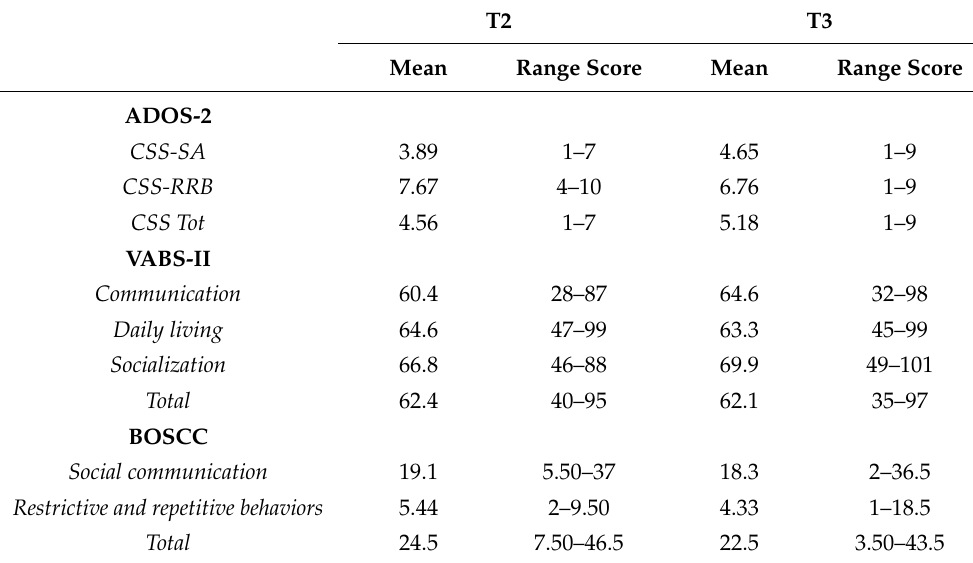
Table 4. Mean and range score in T2 and